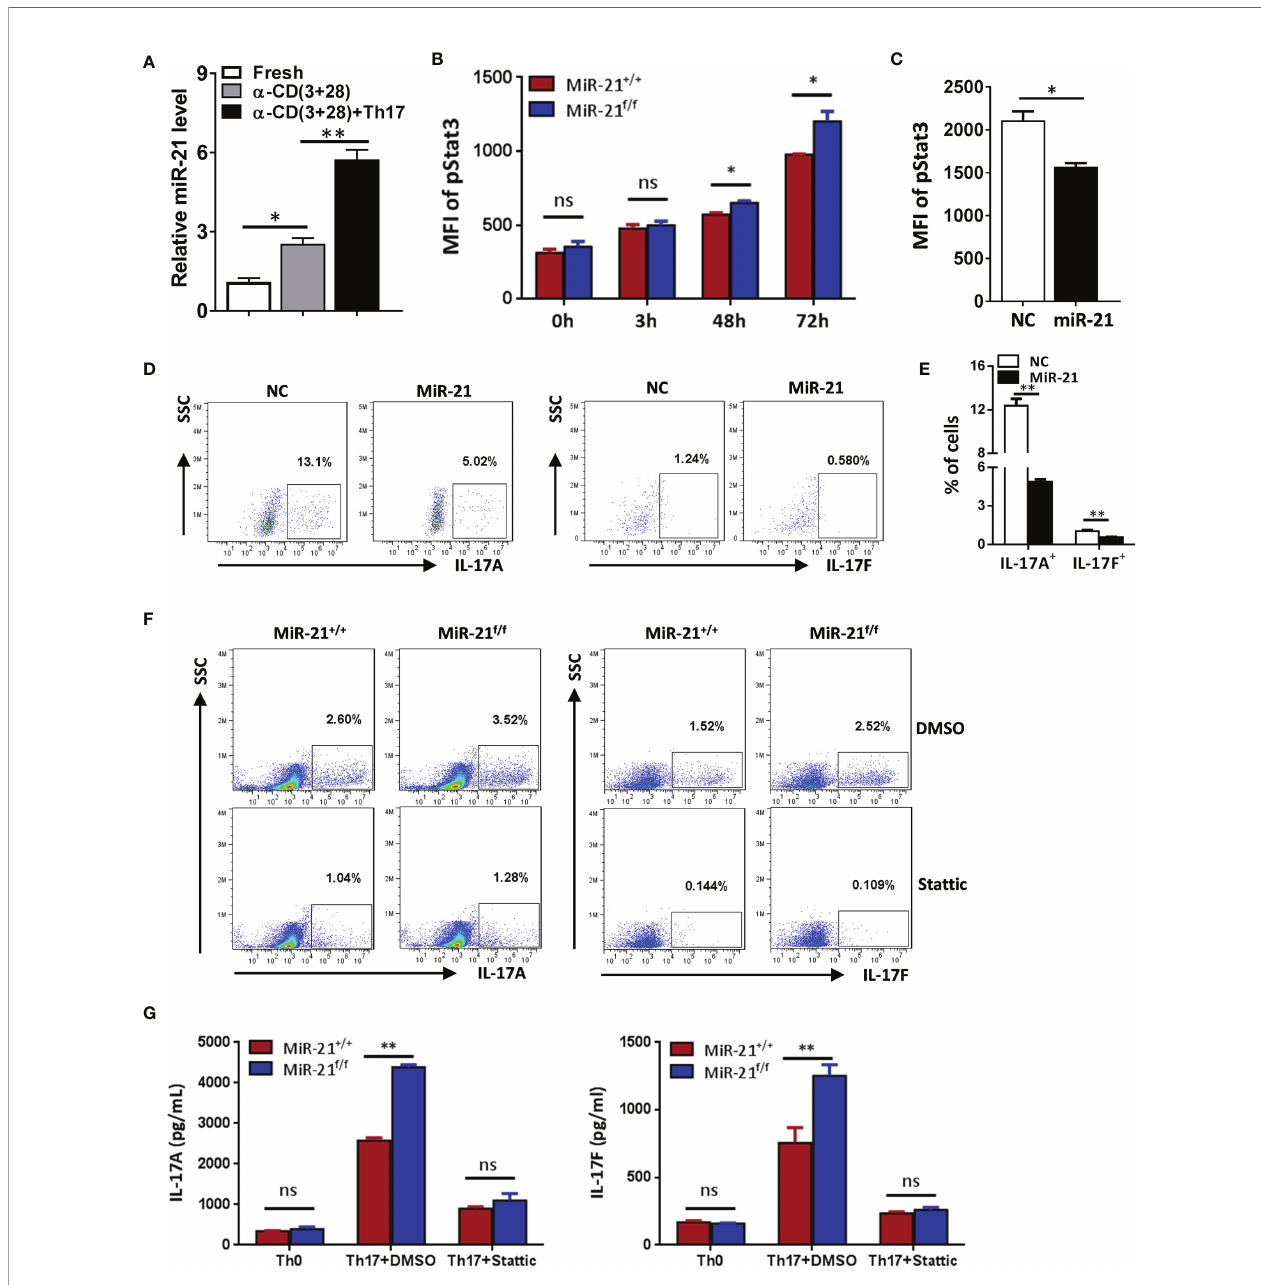
FIGURE 4 | MiR-21 in Treg cells suppresses IL-17 expression through down-regulating Stat3 activity. (A) CD4 + CD8 - YFP + cells were fl ow sorted from the spleen of Foxp3 Cre-YFP miR-21 +/+ mice (n=3) and either untreated or treated with a -CD3 plus a -CD28 in the absence or presence of Th17 priming cytokines for 48 h, and then miR-21 level was determined by quantitative RT-PCR. (B) CD4 + CD8 - YFP + cells were fl ow sorted from the spleen of Foxp3 Cre-YFP miR-21 +/+ (MiR-21 +/+ ) and Foxp3 Cre-YFP miR-21 f/f (MiR-21 f/f ) mice (n=5). Cells were then cultured with a -CD3 plus a -CD28 in the presence Th17 priming cytokines. Cells were collected at the indicated time-points and fi xed, permeabilized, and stained with anti-Stat3. The MFI of pStat3 was determined by fl ow cytometry. (C-E) CD4 + CD25 + Treg cells were isolated from the spleen of C57BL/6 mice using EasySep Mouse CD4 + CD25 + Treg Cell Isolation Kit and cultured with a -CD3 plus a -CD28 and IL-2 for 48 h before control adenovirus (NC) or adenovirus over-expressing miR-21 (miR-21) were added. After culture for another 48 h, cells were treated with Th17 priming cytokines for 72 h. Cells were then fi xed, permeabilized, stained with anti-Stat3, anti – IL-17A, anti – IL-17F, and examined by fl ow cytometry. The quanti fi cation of the MFI of pStat3 was shown in (C) . The percentages of IL-17A + and IL-17F + cells were plotted (D) and quanti fi ed (E) . Cells shown in (D) were gated on transduced cells. (F, G) CD4 + CD8 - YFP + cells were fl ow sorted from the spleen of Foxp3 Cre-YFP miR-21 +/+ (MiR-21 +/+ ) and Foxp3 Cre-YFP miR-21 f/f (MiR-21 f/f ) mice (n=5). Cells were pre- treated with either DMSO or Stat3 inhibitor (Stattic) for 1h and then cultured with a -CD3 plus a -CD28 in the presence of Th17 priming cytokines for 72 h. Cells were then fi xed, permeabilized, and stained with anti – IL-17A, anti – IL-17F, and examined by fl ow cytometry (F) . In addition, culture supernatants were collected and the protein levels of IL-17A and IL-17F (G) were determined by ELISA. Cells cultured with a -CD3 plus a -CD28 (Th0) were used as negative control for Th17 cell differentiation. Data are representative of two to three separate experiments. ns, no signi fi cance. *p < 0.05, **p <